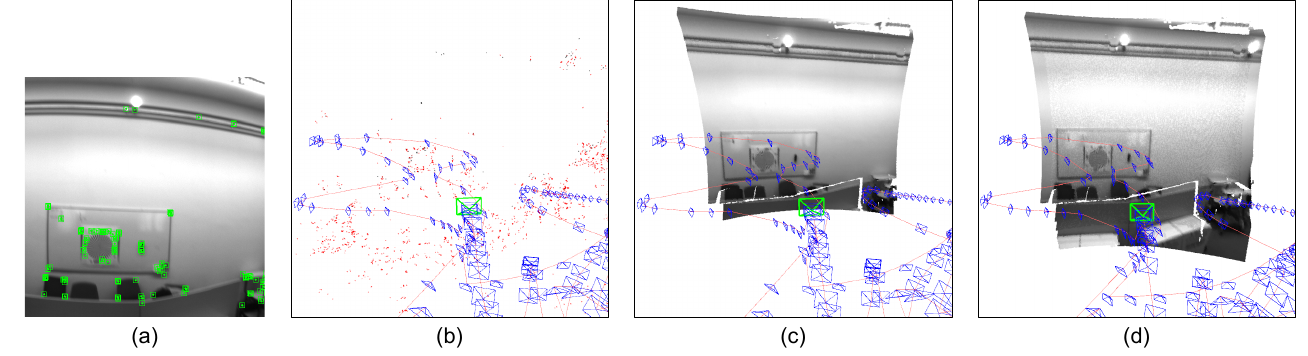
Figure 11. Textureless environments: a white wall. ( a ) The current 2D perspective with sparse feature points; ( b ) 3D sparse mapping from ORB-SLAM3; ( c ) 3D dense point cloud mapped from the current perspective; ( d ) 3D local dense mapping of the current sliding-window. There are few feature points on the white wall so that the sparse map generated from ORB-SLAM3 does not contain the information from the white wall. However, the depth completion network in the proposed system can predict dense depth maps so that the system is able to perform 3D local dense mapping, even in these textureless